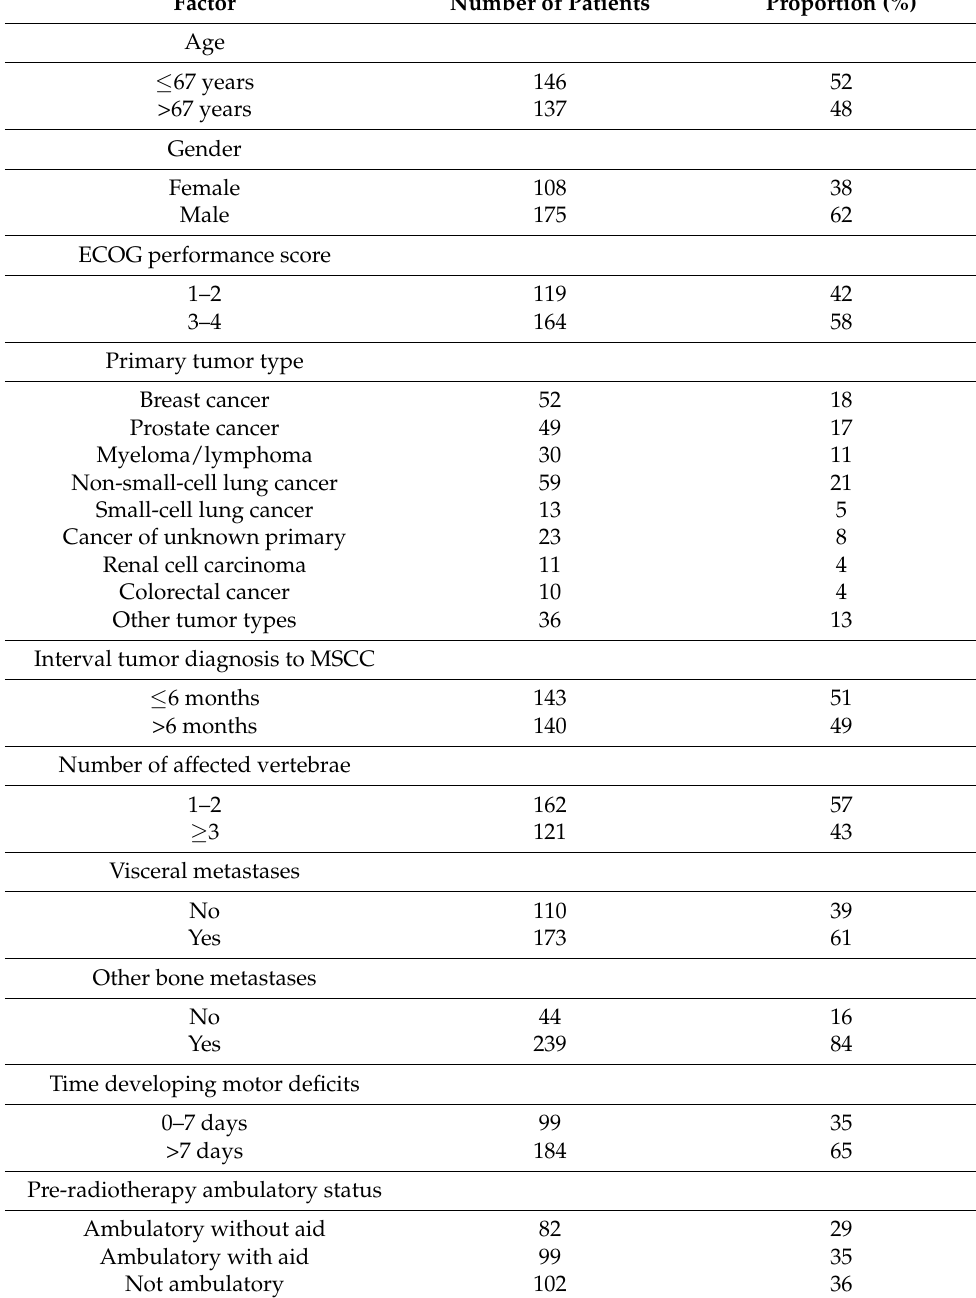
Table 4. Potential prognostic factors evaluated for post-radiotherapy ambulatory status.